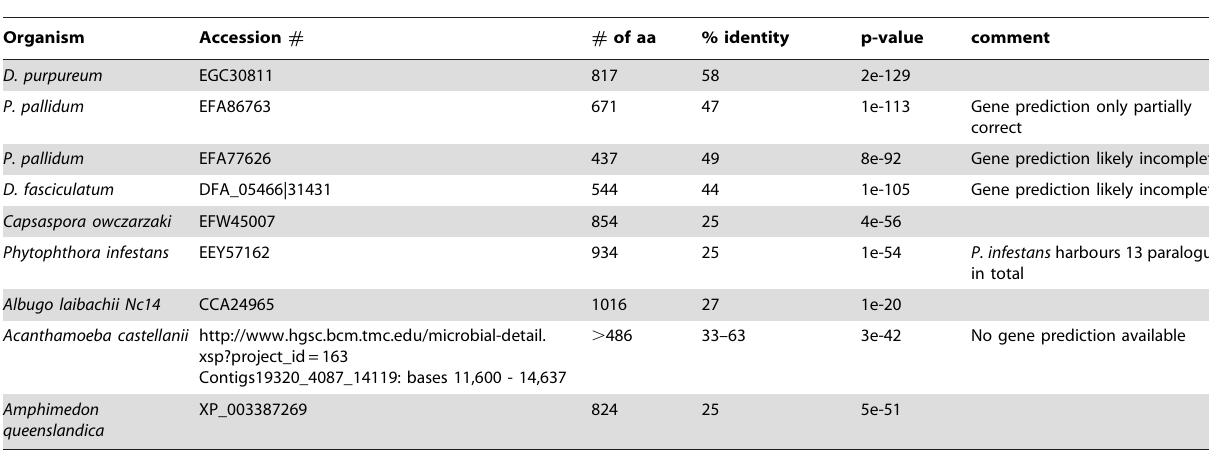
Table 1. Orthologues of RpkA in lower